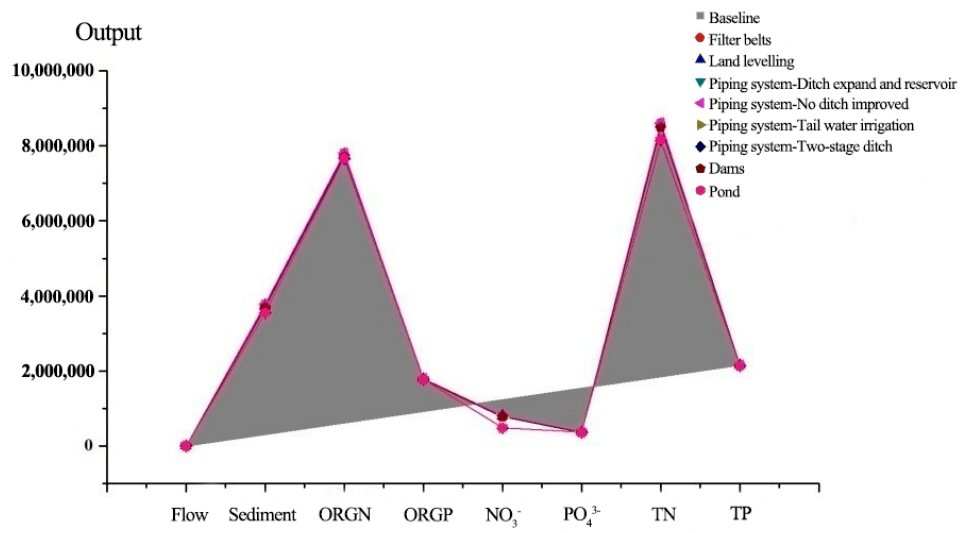
Figure 3. The comparison between the baseline and the scenarios. (Flow unit: kg/m 3 ; Sediment unit: t; Pollutants unit: kg).